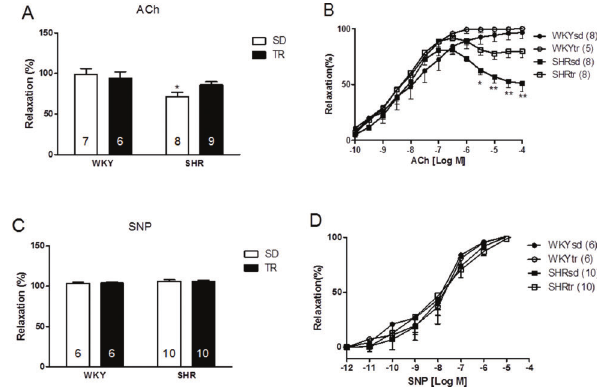
Figure 2 - Relative maximal endothelium-dependent vasorelaxa- tion induced by ACh (A) and relative maximal endothelium- independent vasorelaxation following the SNP treatment (C). Curves showing the maximal endothelium-dependent vasore- laxation (ACh: 10 –10 to 10 –4 M) and maximal endothelium- independent vasorelaxation (SNP: 10 –12 to 10 –4 M) (B and D, respectively) of the aortas of control WKY (circles) and SHR (square). * p o 0.01 and ** p o 0.001 SHRsd group compared with the WKYsd, WKYtr and SHRtr groups. The data are presented as the mean ± SEM.